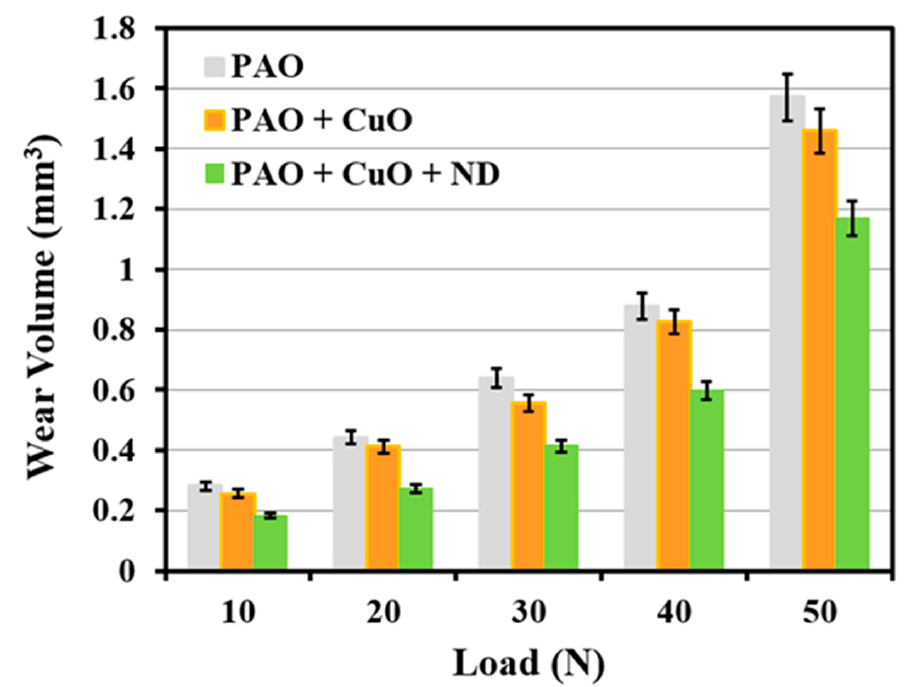
Figure 2. Wear volume of Al alloy discs (mm 3 ) in the presence of PAO base oil, PAO + CuO and PAO + CuO + ND nanolubricants, with an increase in applied load from 10 N to 50 N.